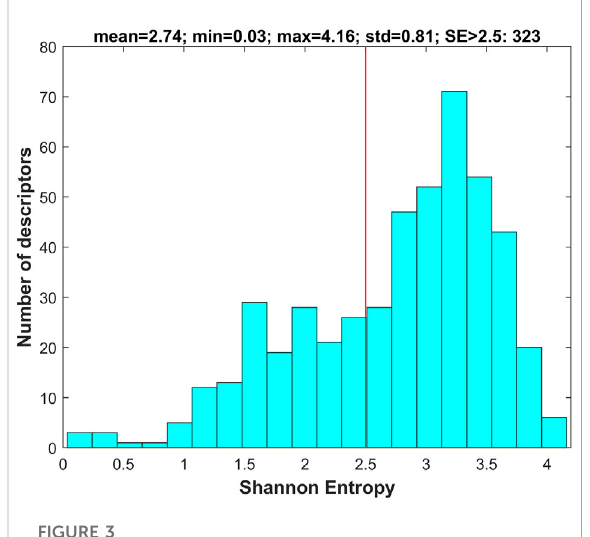
FIGURE 3 Shannon entropy of molecular descriptors. The x -axis indicates Shannon entropy and the y -axis depicts the number of descriptors. The red line marks the threshold of Shannon entropy for fi ltering descriptors with Shannon entropy < 2.5.